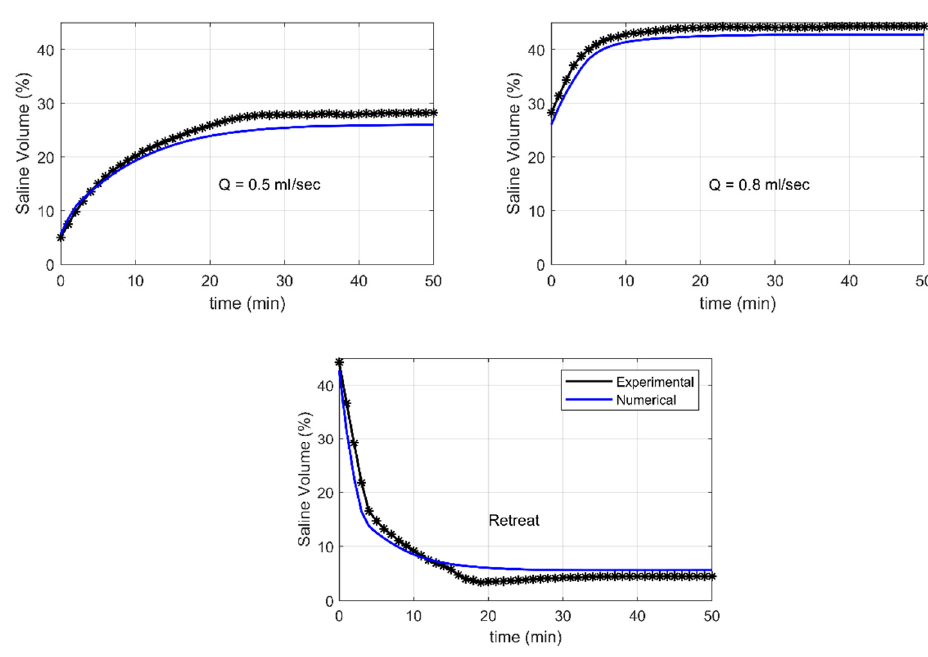
Figure 5. Transient experimental and numerical values of the saline volume fraction in the fractured-center aquifer, under an abstraction rate of 0.5 mL/s ( top left ) and 0.8 mL/s ( top right ) as well as during the final saltwater retreat phase ( bottom ).